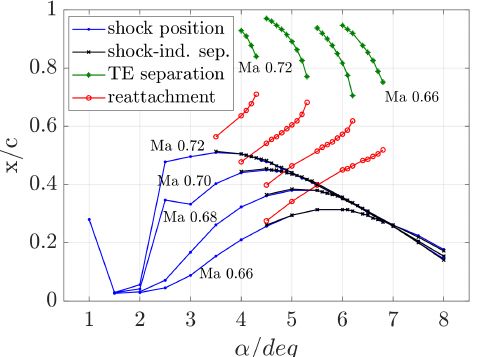
Figure 5. Trends in separation and reattachment for the different Mach